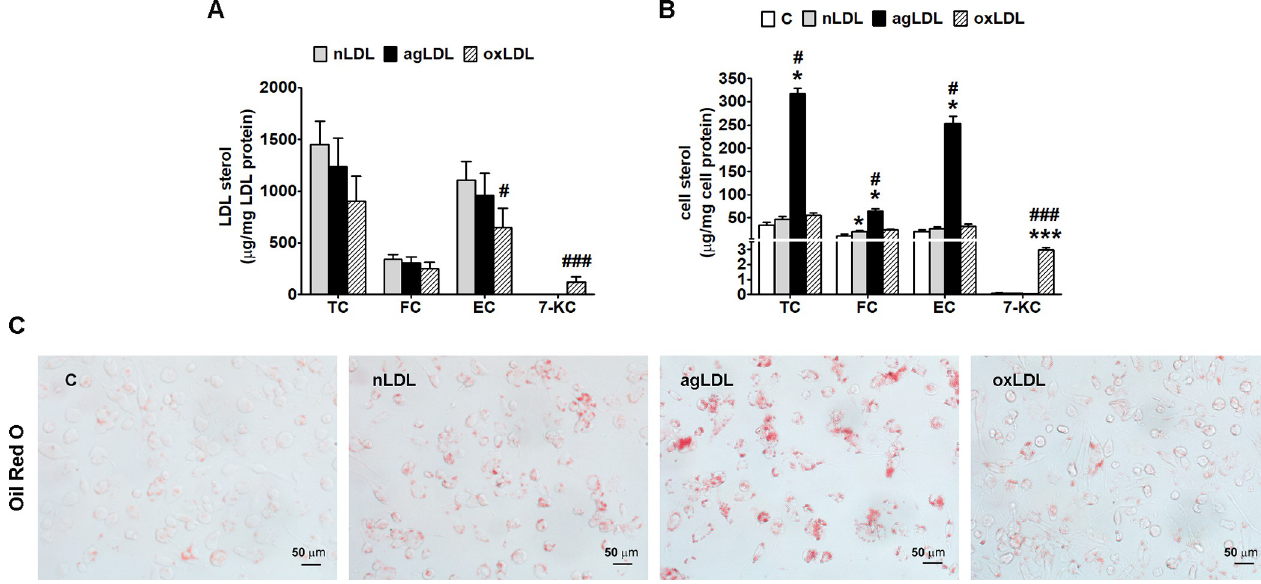
Fig 1. AgLDL induce intracellular cholesterol accumulation in THP-1 macrophages. Cells were exposed for 24 h to 100 μ g/ml aggregated LDL (agLDL), oxidized (oxLDL) or native LDL (nLDL). Cells incubated in the same conditions without LDL were considered control cells (C). (A) Total (TC), free (FC) and esterified cholesterol (EC) and 7-ketocholesterol (7-KC) levels in agLDL, oxLDL and nLDL analyzed by GC-MS and expressed as LDL sterol relative to LDL protein. (B) Intracellular TC, FC, EC and 7-KC levels analyzed by GC-MS and expressed as cell sterol relative to total cell protein. (C) Oil Red O staining showing neutral lipid accumulation, bar = 50 μ m. All data are expressed as fold change versus C and presented as mean ± SD (n = 4). � p < 0.05, ��� p < 0.001 vs. C; # p < 0.05, ### p < 0.001 vs. nLDL. https://doi.org/10.1371/journal.pone.0245797.g001 PLOS ONE | https://doi.org/10.1371/journal.pone.0245797 January 25,